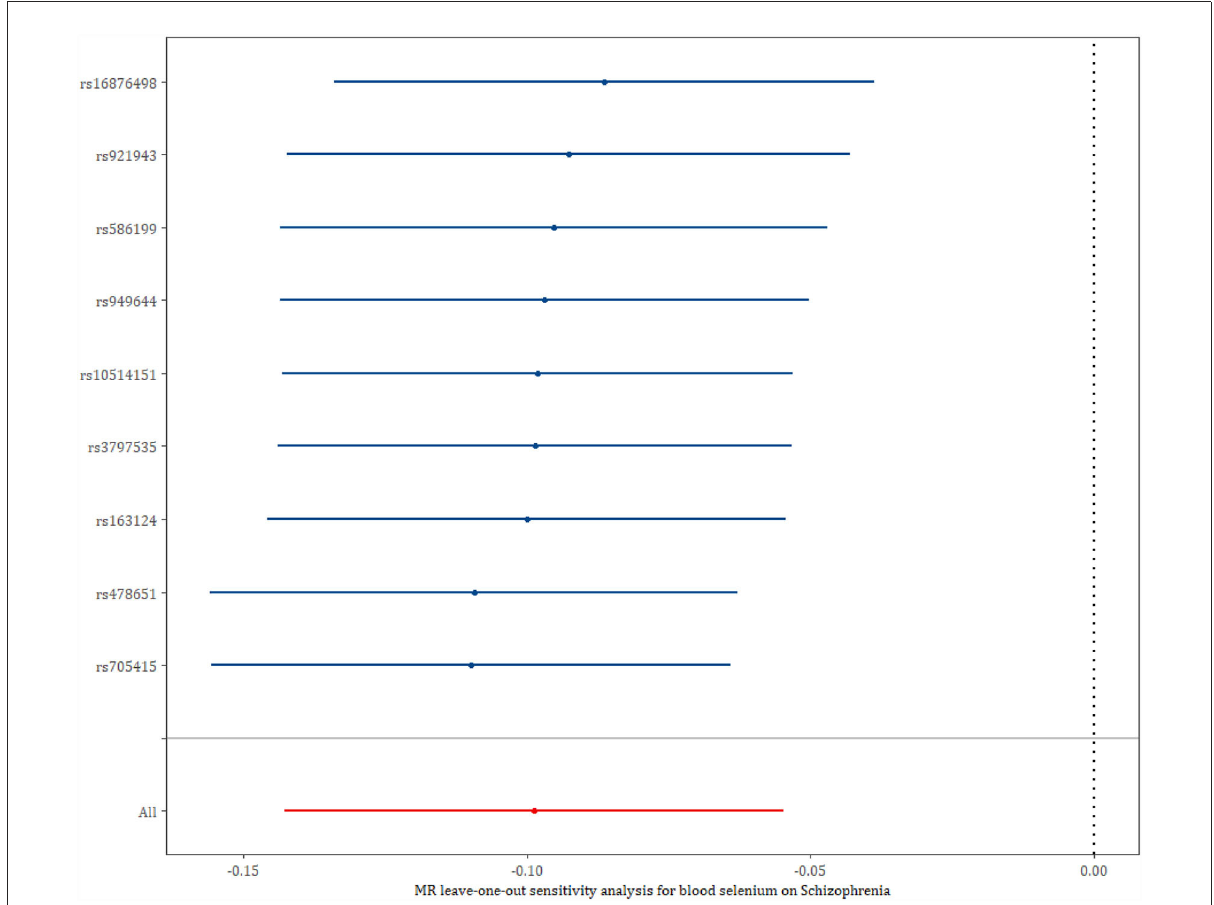
FIGURE2 The leave-one-out analysis of genetic variants on schizophrenia.